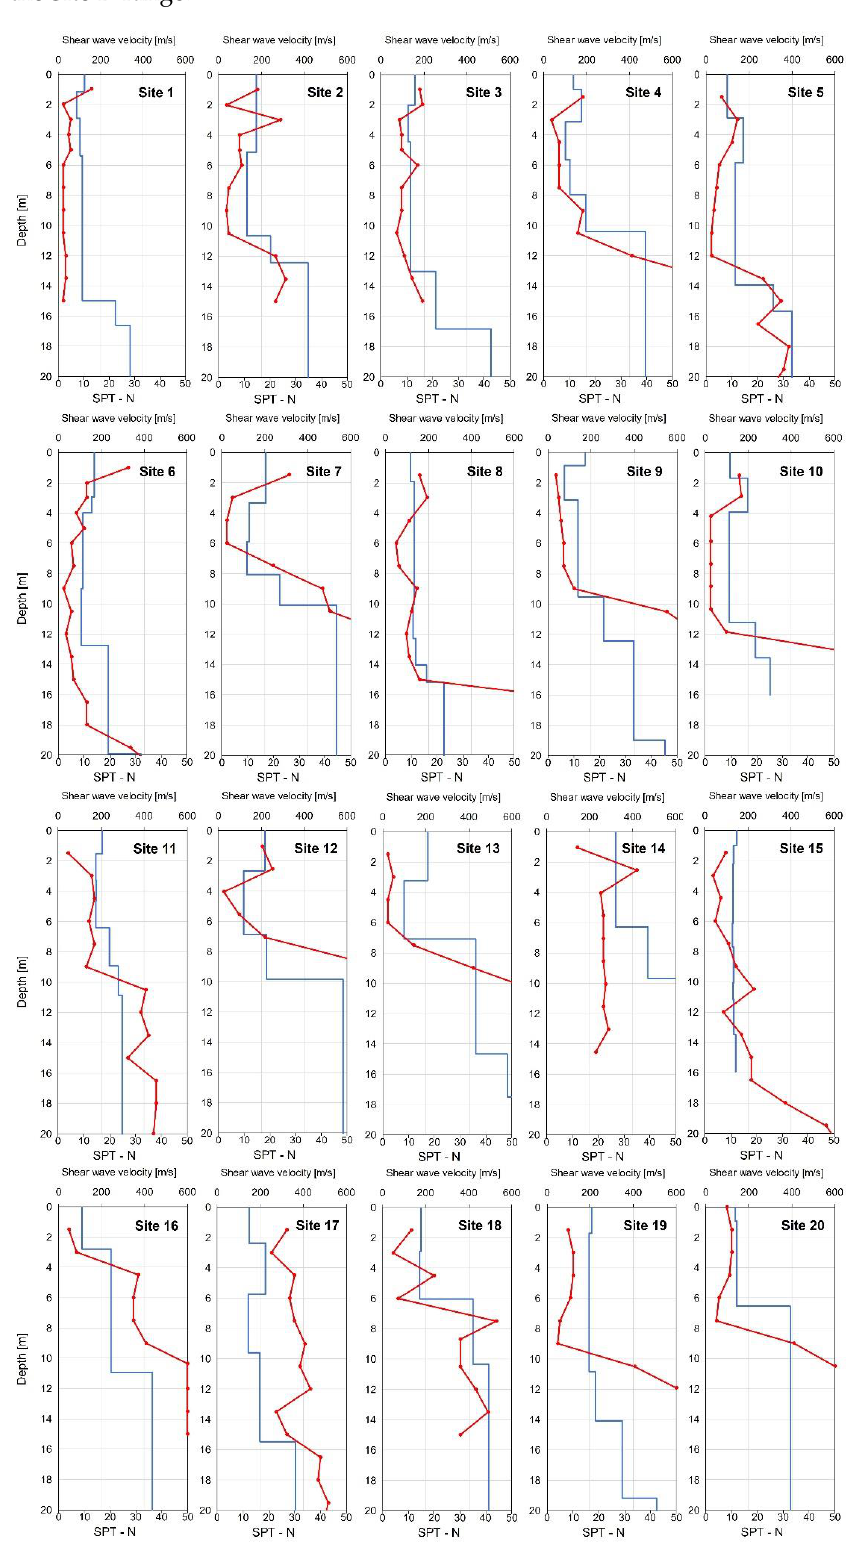
Figure 3. Variation of shear wave velocity (V s ) and penetration resistance (SPT-N) with depth for all twenty sites. Legend: blue lines for shear wave velocities; red lines for SPT-N values.